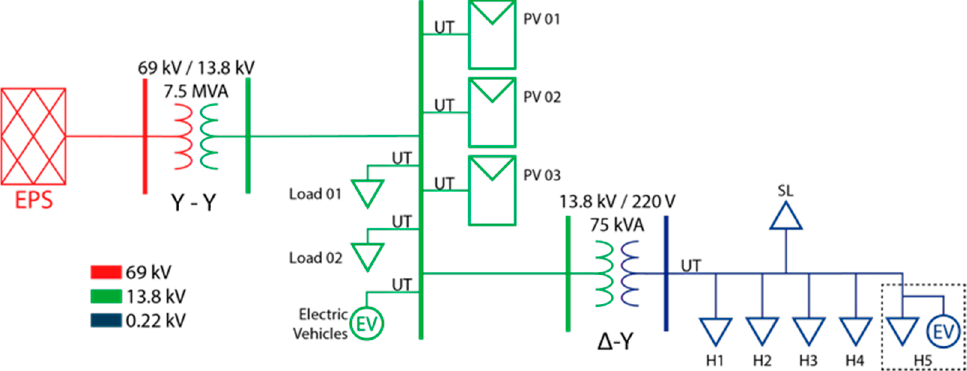
Figure 3. Electrical Region with VPP.